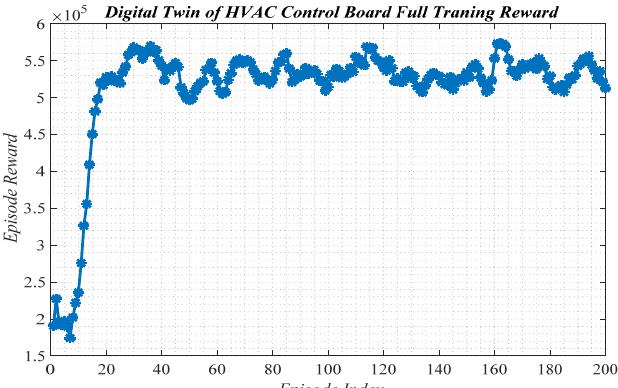
Figure 10. The trend of average reward in the SIL environment.